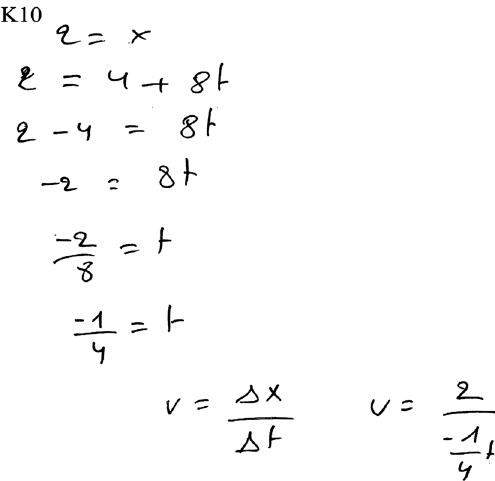
FIG. 8. Example of case 1 with question K10 in which the equation x ¼ 4 þ 8 t was provided: a numerical interval or point confusion and additionally the Δ in the formula for v is written but not taken into